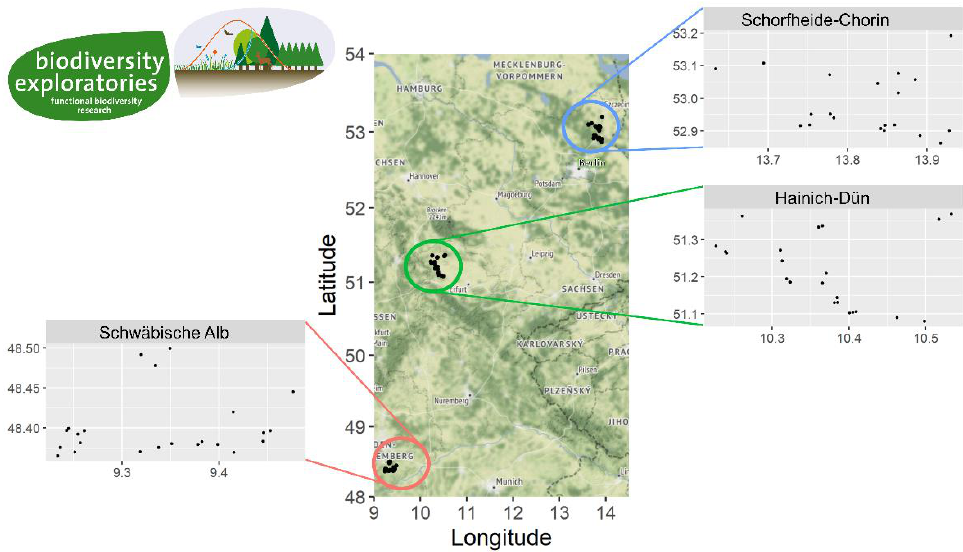
Figure 1. Geographic positions (x-axis: longitude, y-axis: latitude) of 75 experimental study sites within three study regions of the Biodiversity Exploratories project in Germany. Blue—Schorfheide-Chorin (SCH) region, green—Hainich-Dün (HAI) region and red—Schwäbische Alb (ALB) region.